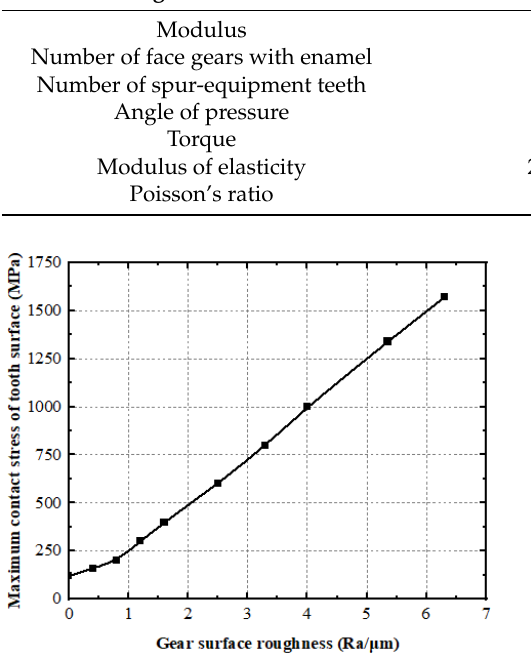
Figure 10. Impact of roughness on the face-gear maximum contact stress.